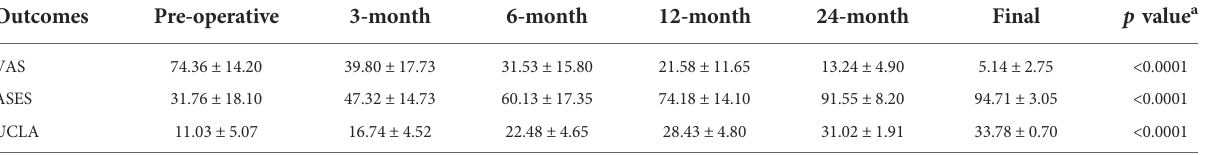
TABLE 2 Pre-operative and post-operative VAS, ASES, and UCLA scores.